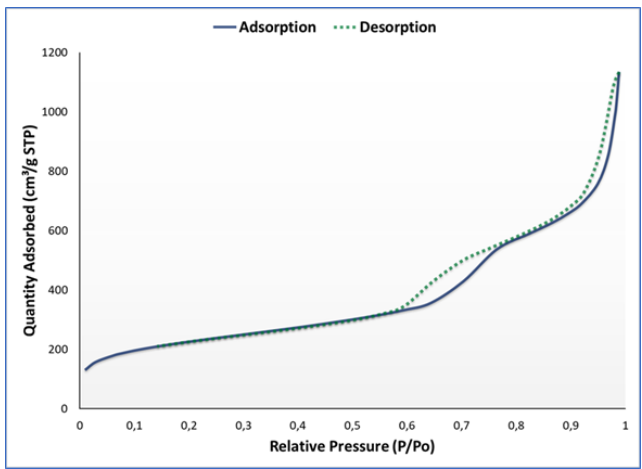
Figure 3. Nitrogen adsorption-desorption isotherm for synthesized MSN.